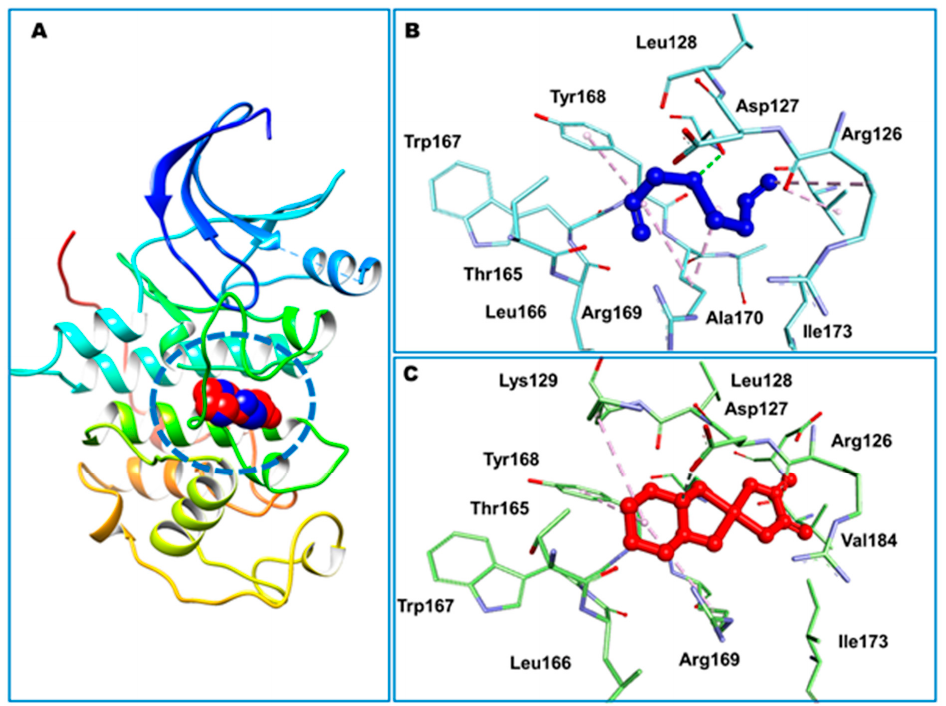
Figure 2. Docked compounds DADS and OXA, shown in blue and red color, respectively. Cyclin- dependent kinase 2 protein is in ribbon style, while docked ligands occupying the binding site are presented as CPK rendering ( A ). Minimum energy conformation of DADS ( B ) and OXA ( C ) are shown as ball and stick, while interacting residues are displayed as sticks. Intermolecular interactions are depicted as broken lines.